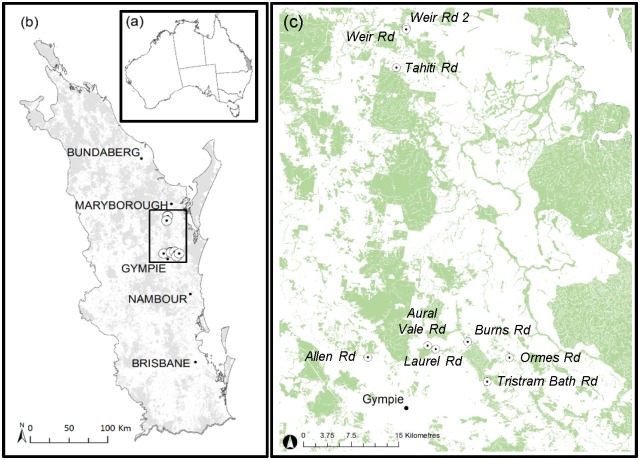
Map of the study area showing (a) its position within southeast Queensland, (b) population locations and remnant vegetation [20] in southeast Queensland, and (c) Population locations and remnant vegetation of the northern and southern sampling sites in greater detail.